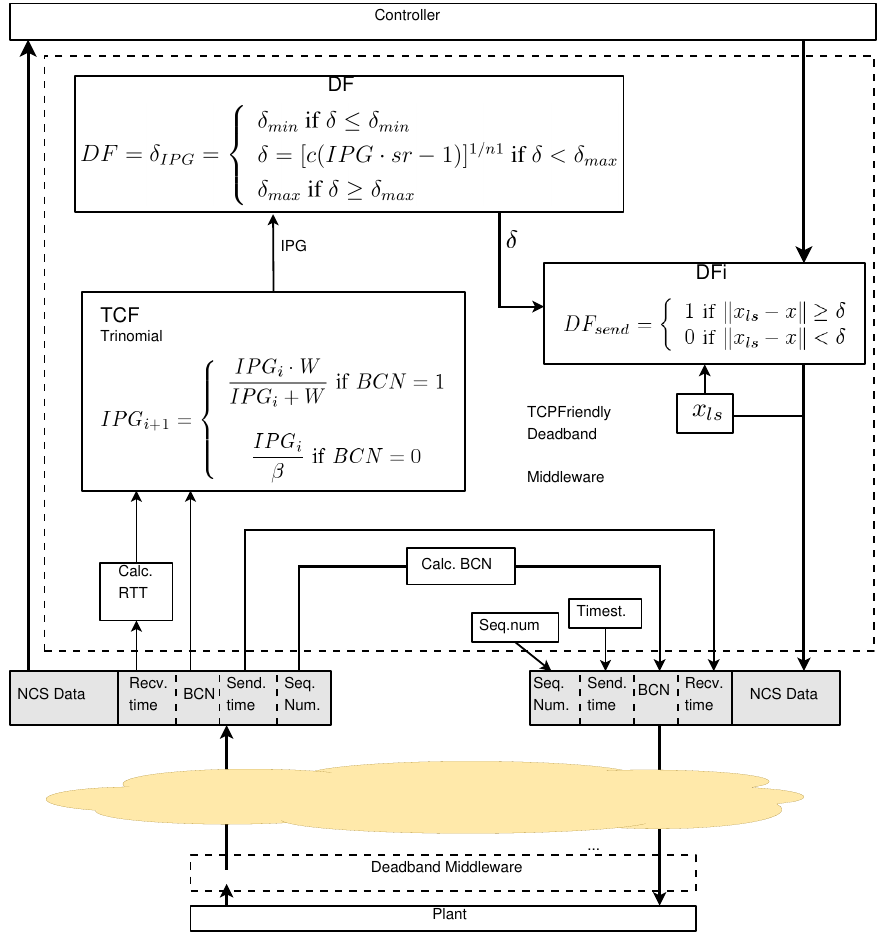
Figure 6. TCP-friendly adaptive